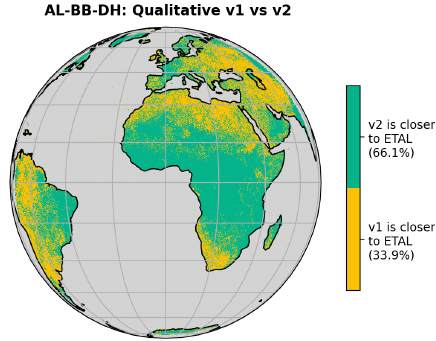
Figure A2. Qualitative comparison of performance of MDAL v1 and v2 with respect to ETAL for AL-BB-DH.